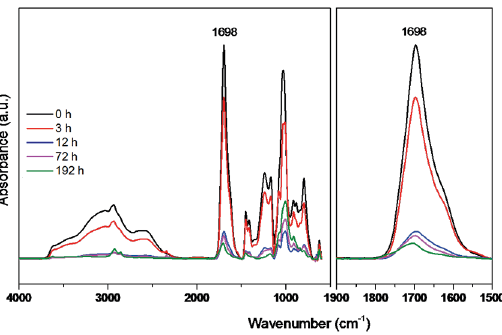
Figure 6. FTIR-ATR spectra of PAA/30%SWy-1 nanocomposite film as a function of irradiation time.